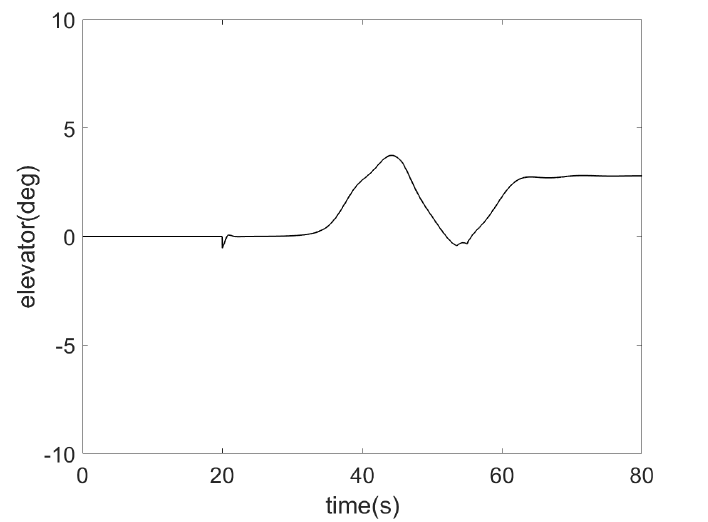
Figure 17. The time evolution of